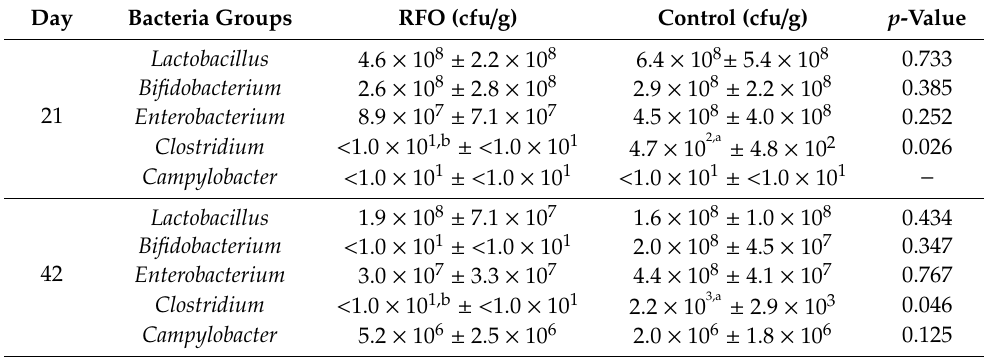
Table 6. Quantification of major commensal bacteria strains prone to modulation with prebiotics and representing the bacteriological status of chicken